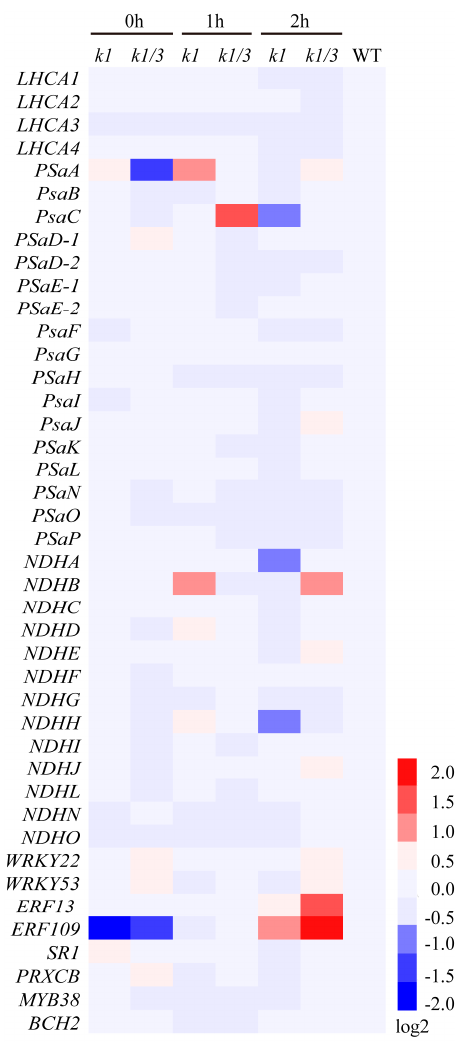
Figure 7. Heat map of gene expression in kowhy1 and ko1/3 mutants after high light treatment. Gene expression in kowhy1 , ko1/3 mutants after high light treatment was analyzed by qPCR. The transcript level in each case was normalized to that of GAPC2 as a reference gene, and the expression level of WT was set as 1. Three biological replications were used to analyze. Heat map were drawn by Heml software used log2 of expression.